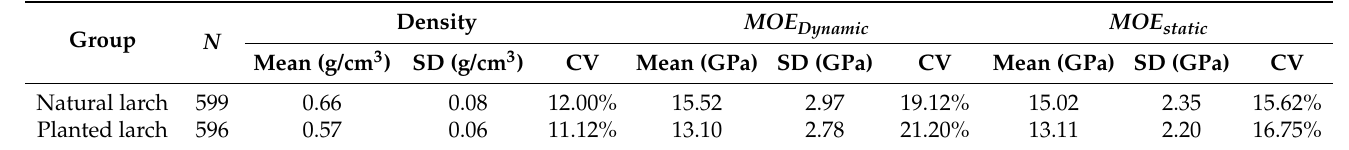
Table 2. Density and MOE statistics of the two-dimensional larch lumber types.